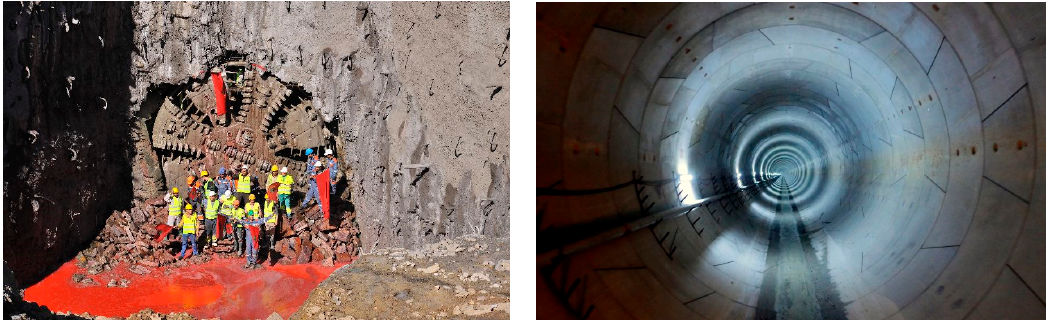
Figure 8. Construction works of the Bouskoura underground super collector (Source: Casa